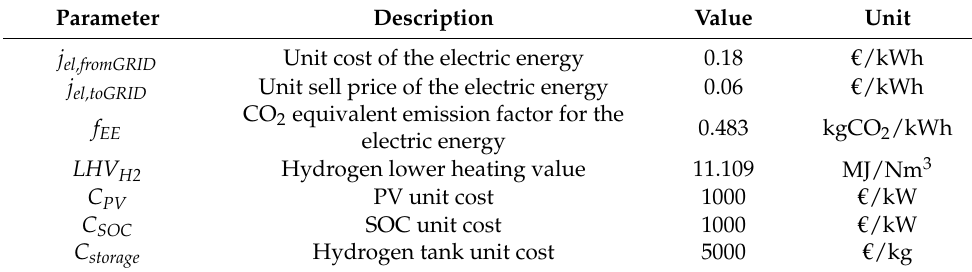
Table 1. Thermoeconomic